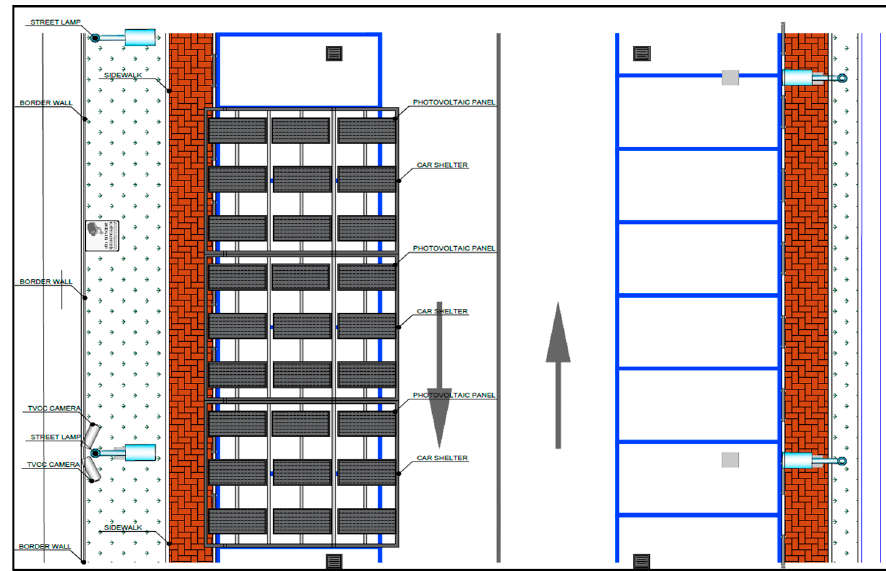
Figure 13. Concept of installation (top view).